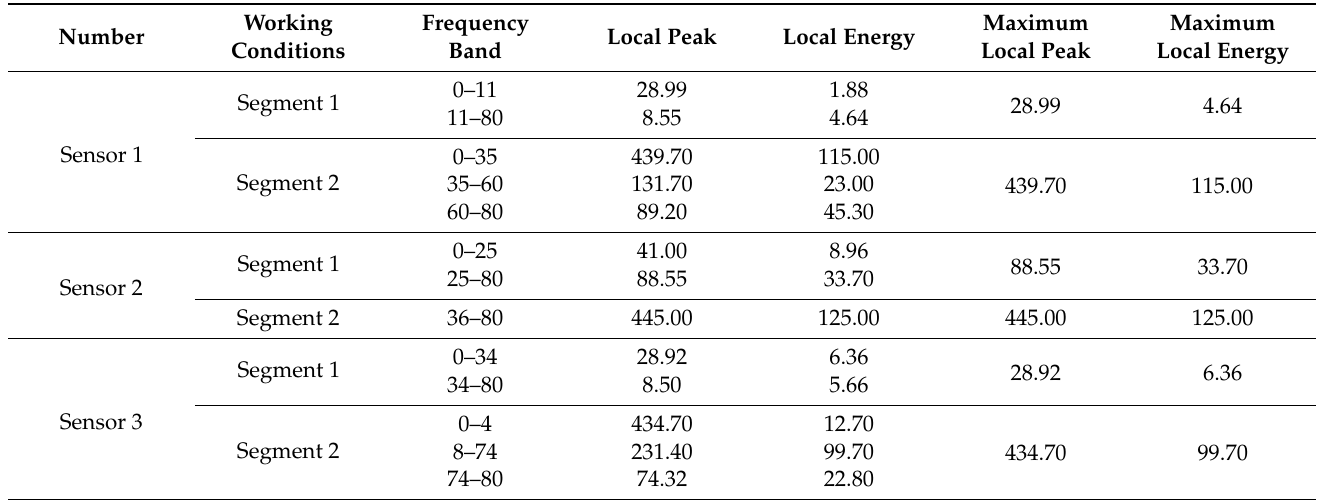
Table 7. Local peak and energy in different frequency bands and maximum local peaks and energies.